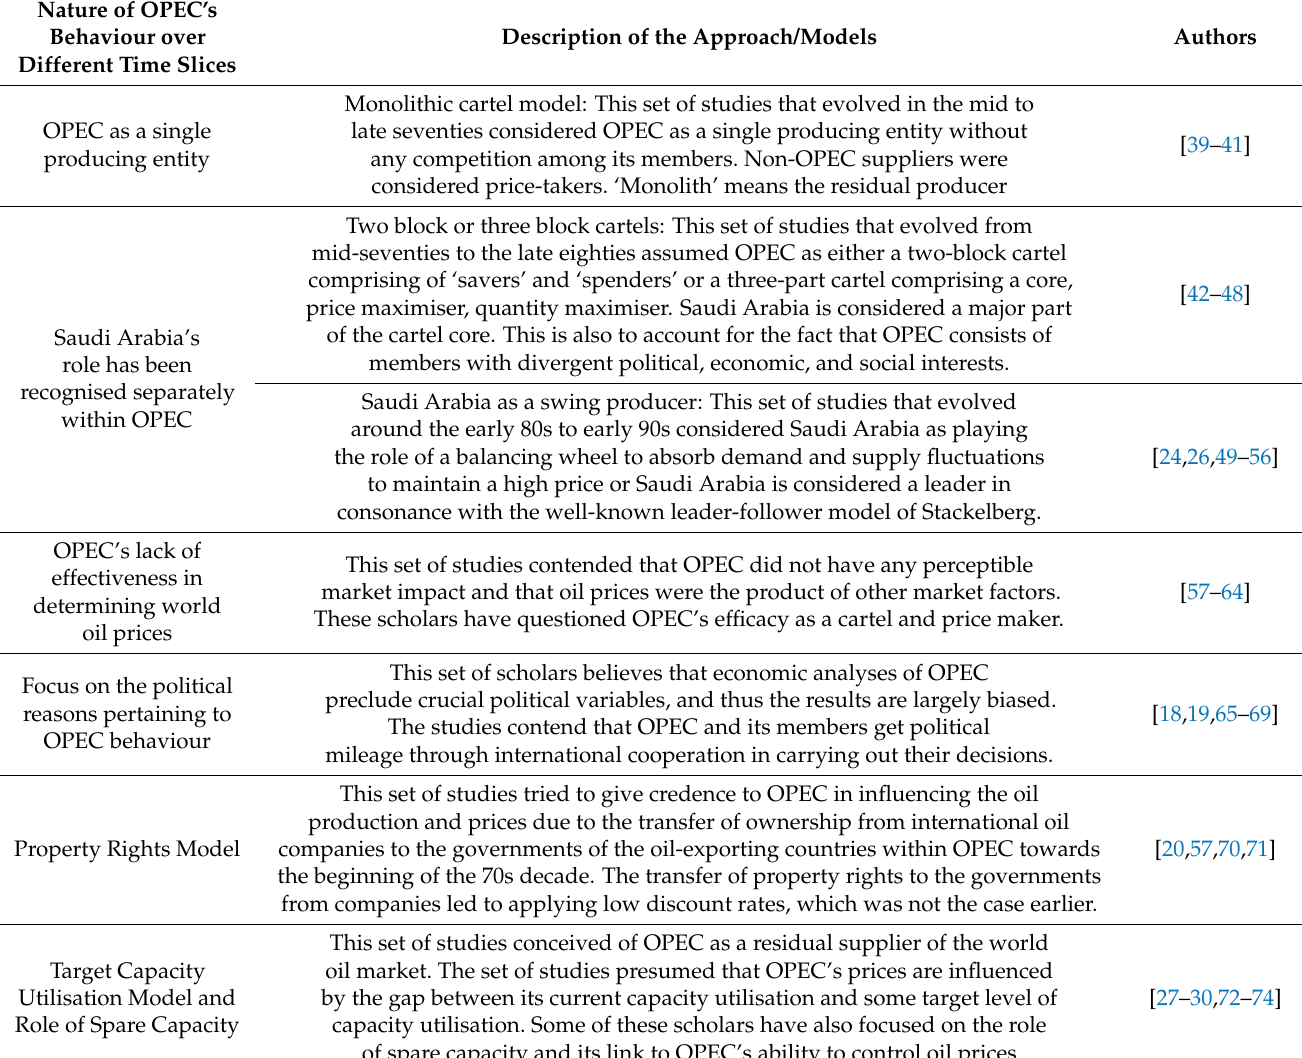
Table 1. Studies on Oil Markets and Role of